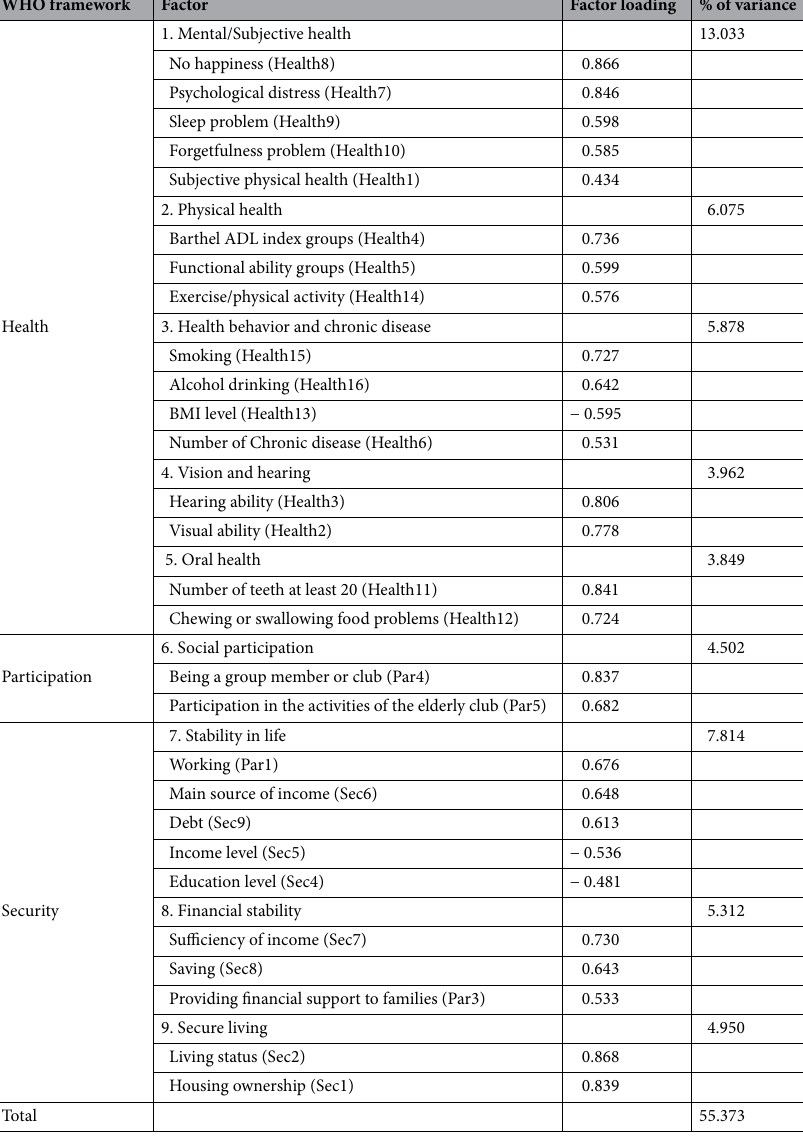
Table 2. Structural and factor loading of active aging items among rural elderly (n = 1,098). Factor loadings lower than 0.3 were omitted (Health17, Par2, Par6,